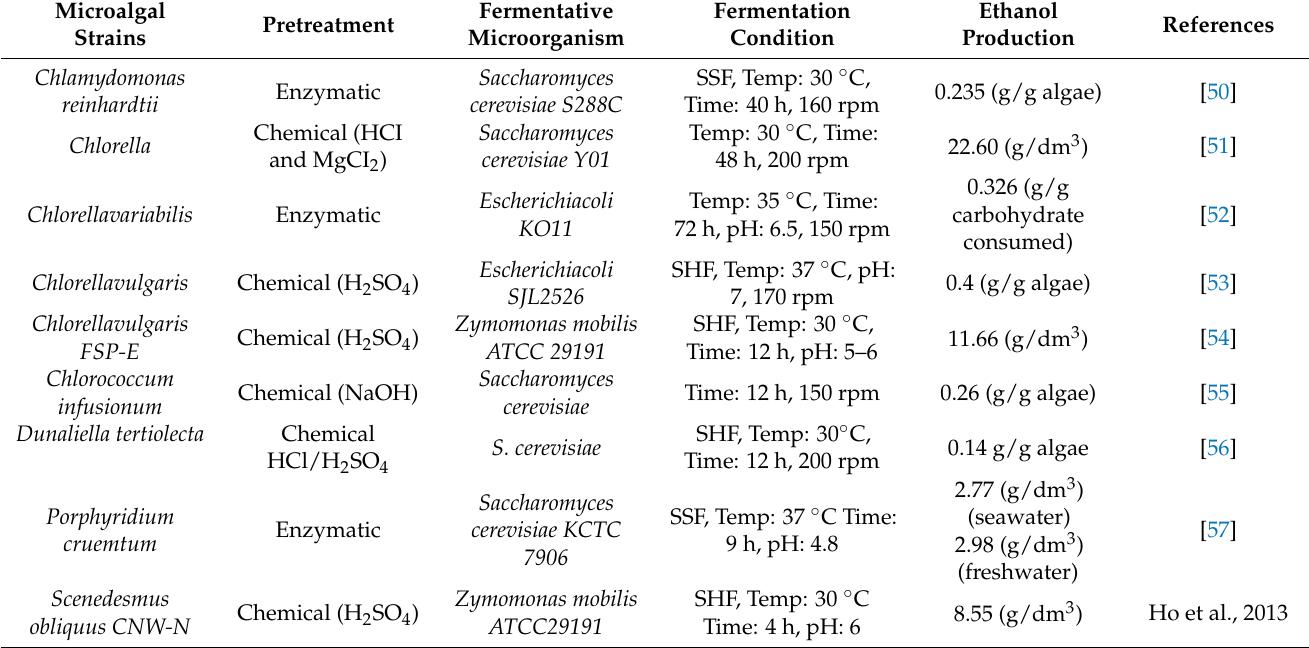
Table 2. Ethanol production from various microalgae using different pretreatment and fermentative